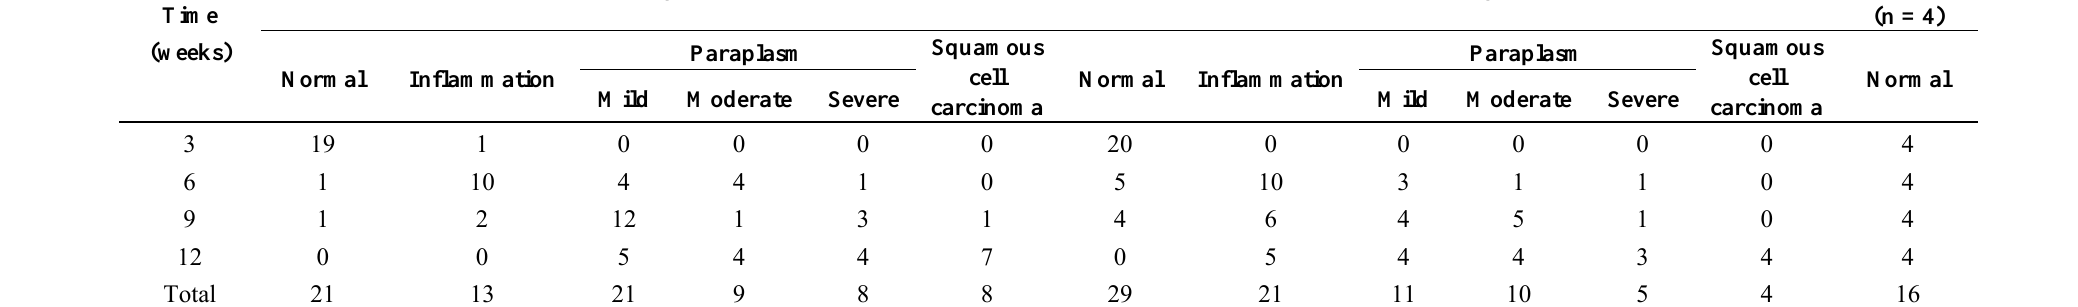
Table 4. Results of histopathologic observation.